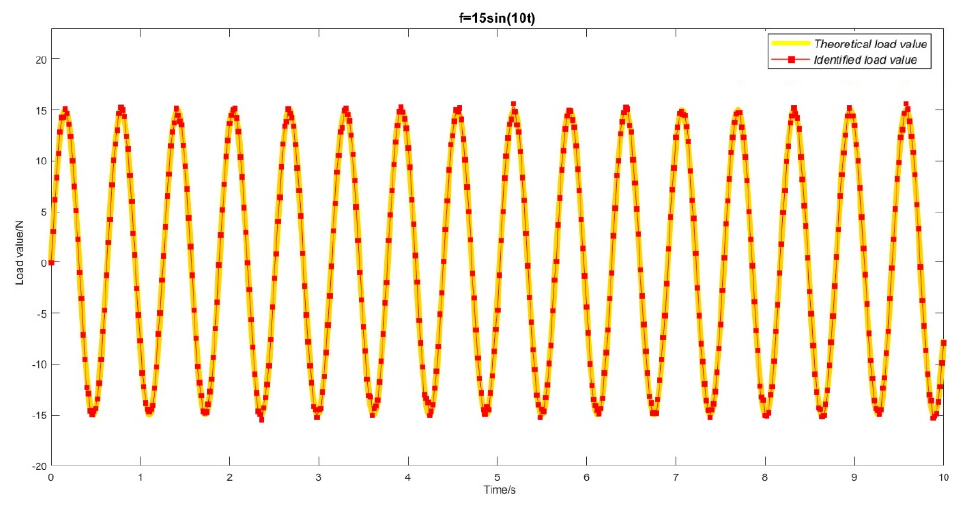
Figure 5. Single-degree-of-freedom system load-identification results. Figure 6 indicates that the load identified by the Newmark method has good identi- fication accuracy in the first 5 s and then starts to diverge; the error exceeds 100% after 8 s. However, there are no corresponding problems in the function principle identification method; the load identification of each micro segment is independent of the others, and there is no accumulated error.